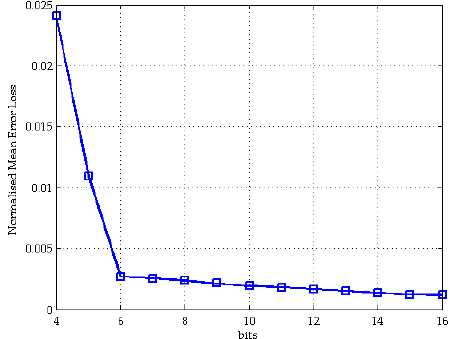
Figure 7. Normalized mean error loss against the standard SDM.